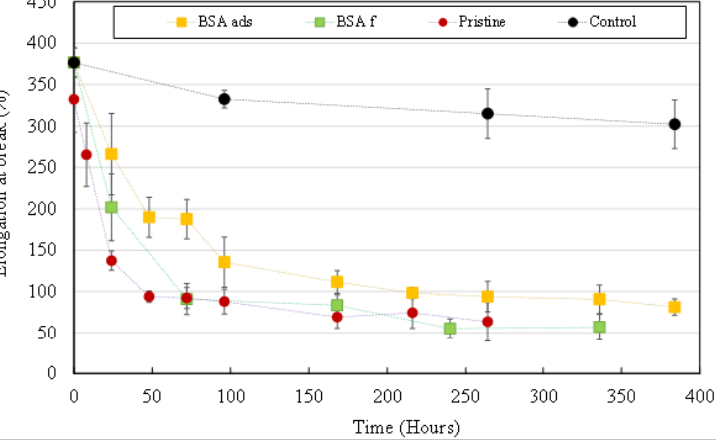
Figure 8. Average thickness of HFs ’ wall after UV irradiation at 1000 µW/cm². Pristine HFs ( red dots ), BSA pre-adsorbed HFs ( yellow squares ) and BSA pre-filtrated HFs ( green squares ). Control ( black dots ) = pristine HFs without UV irradiation.